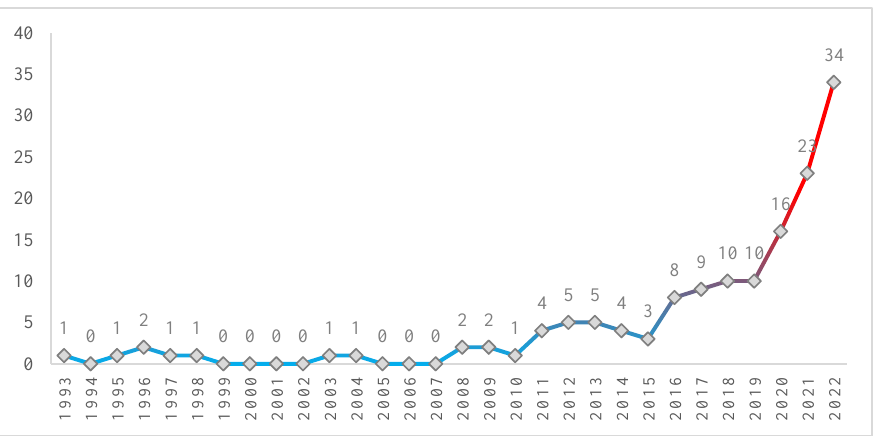
Figure 2. Annual trend of publications of RM in PC.